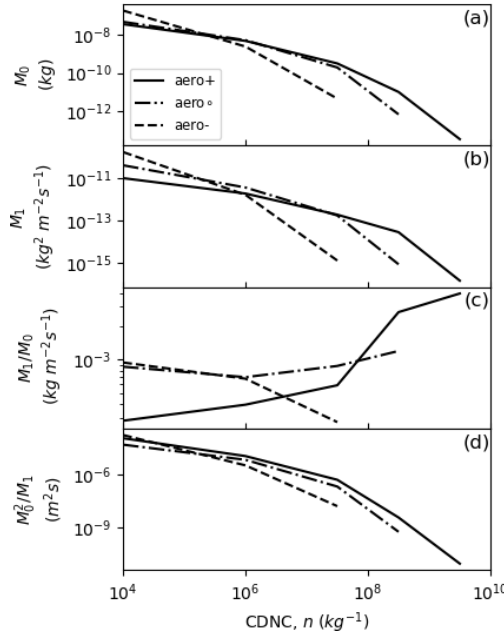
Figure 3. The moment-related properties of the CDNC-conditioned rainfall distributions for each model experiment, as functions of the column-averaged CDNC: (a) the rainfall frequency (per unit CDNC interval), i.e. the zeroth moment, M 0 ( n ), of the CDNC-conditioned rainfall rate distribution, f n ( p ); (b) the CDNC-conditioned rainfall amount, M 1 ; (c) the CDNC-conditioned mean rainfall rate, λ n = M 0 /M 1 ; and (d) the normalised rainfall frequency, ν n = M 2